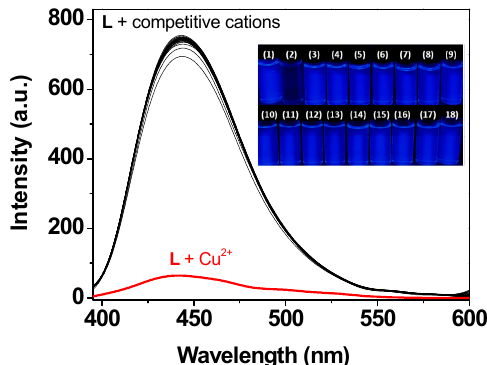
Figure 2. Fluorescence responses of L (10 µ M) in the DMF / HEPES mixed solution (7:3, v / v , pH = 7.4) various cations (60 µ M): (1) Free L , (2) Cu 2 + , (3) Pb 2 + , (4) Cd 2 + , (5) Co 2 + , (6) Ni 2 + , (7) Mn 2 + , (8) Hg 2 + , (9) Ag + , (10) Fe 3 + , (11) Cr 3 + , (12) Al 3 + , (13) Ba 2 + , (14) Ca 2 + , (15) Mg 2 + , (16) Li + , (17) Na + , (18) K + . Excitation at 378 nm.